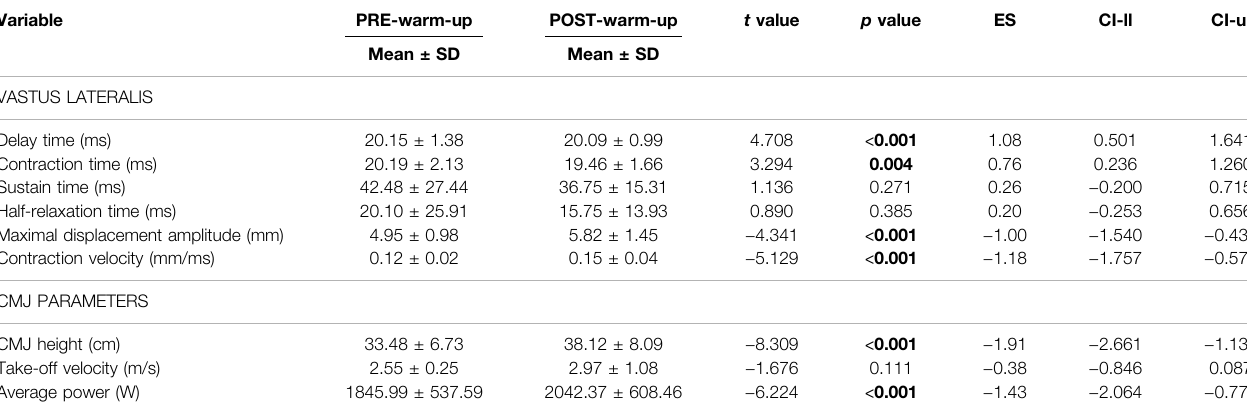
TABLE 2 | Comparison of vastus lateralis muscle contractile properties and jumping performance measures from PRE to POST warm-up protocol.